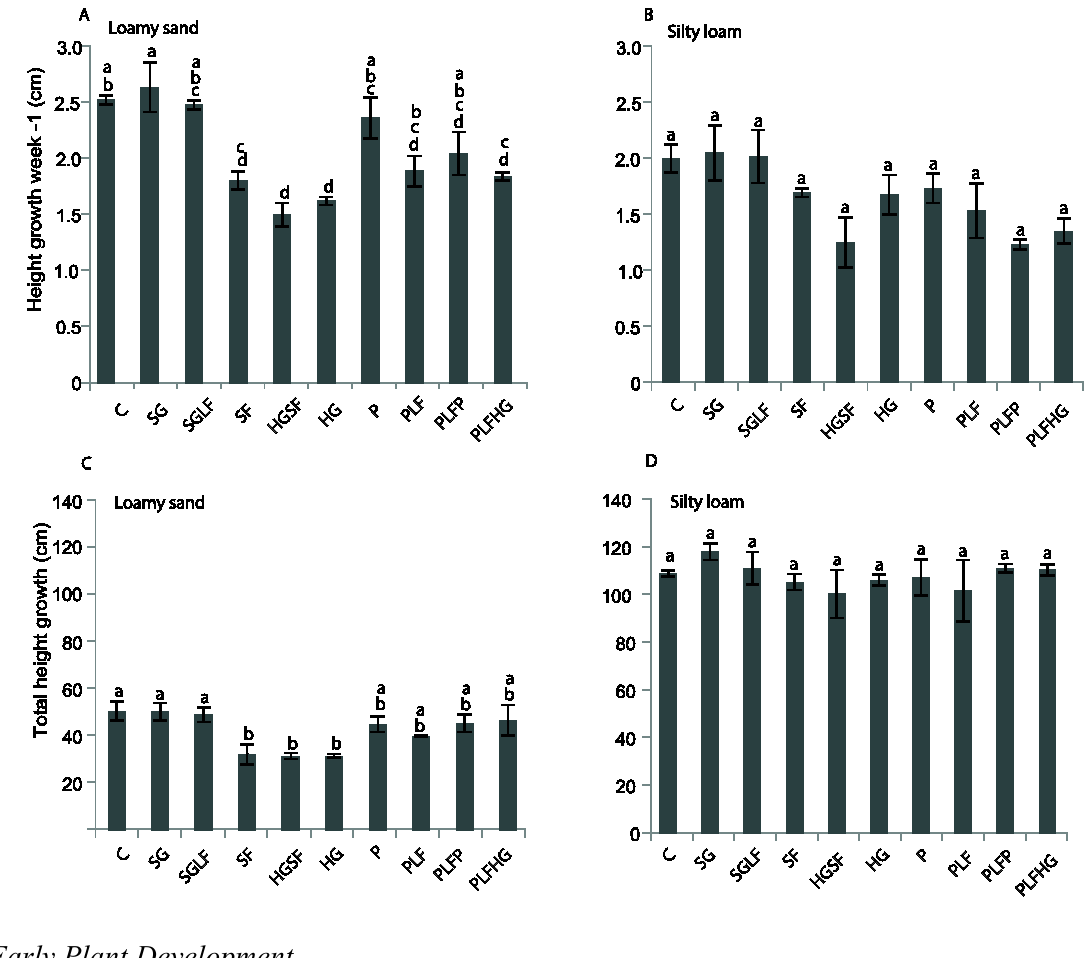
Figure 2. Height growth of P. trichocarpa cuttings after application of fertilizers, hydrogel or the combination of substrates. ( A , B ) height growth week −1 and ( C , D ) height growth after five months. The treatments consisted of no treatment (C), starch gel (SG), starch gel containing liquid fertilizer (SGLF), solid fertilizer (SF), Hydrogel (HG), Hydrogel containing solid fertilizer (HGSF), Perlite (P), Perlite containing liquid fertilizer (PLF), Perlite containing liquid fertilizer diluted with fertilizer-free Perlite (PLFP) and Perlite containing liquid fertilizer and Hydrogel (PLFHG).Data shown are mean values of n = 3 and standard error. Means with the same letter are not significantly separated at the p = 0.05 level. Note the different scales on the Y